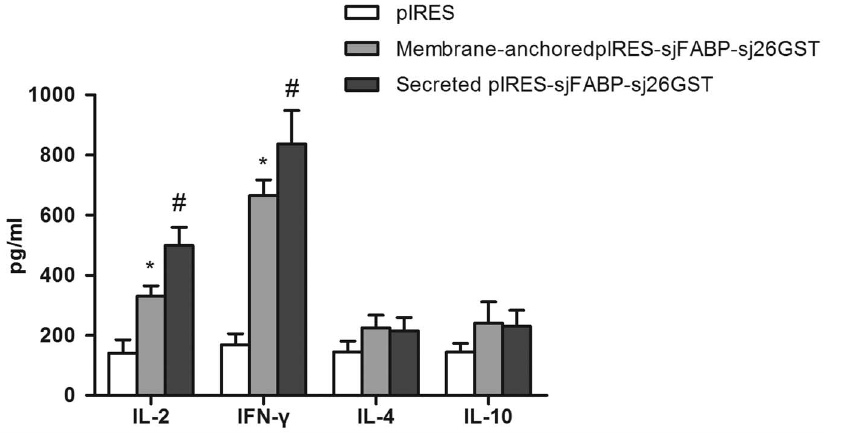
Figure 6. Levels of cytokine production from splenocytes after SWAP stimulation in vitro. Groups of mice were injected with secreted pIRES-sjFABP-sj26GST, membrane-anchored pIRES-sjFABP-sj26GST, and pIRES as control. Data from 3 experiments are expressed as the mean 6 SD. Statistically significant differences (P , 0.05) are indicated by *compared with the control group, or # compared with the membrane-anchored group.